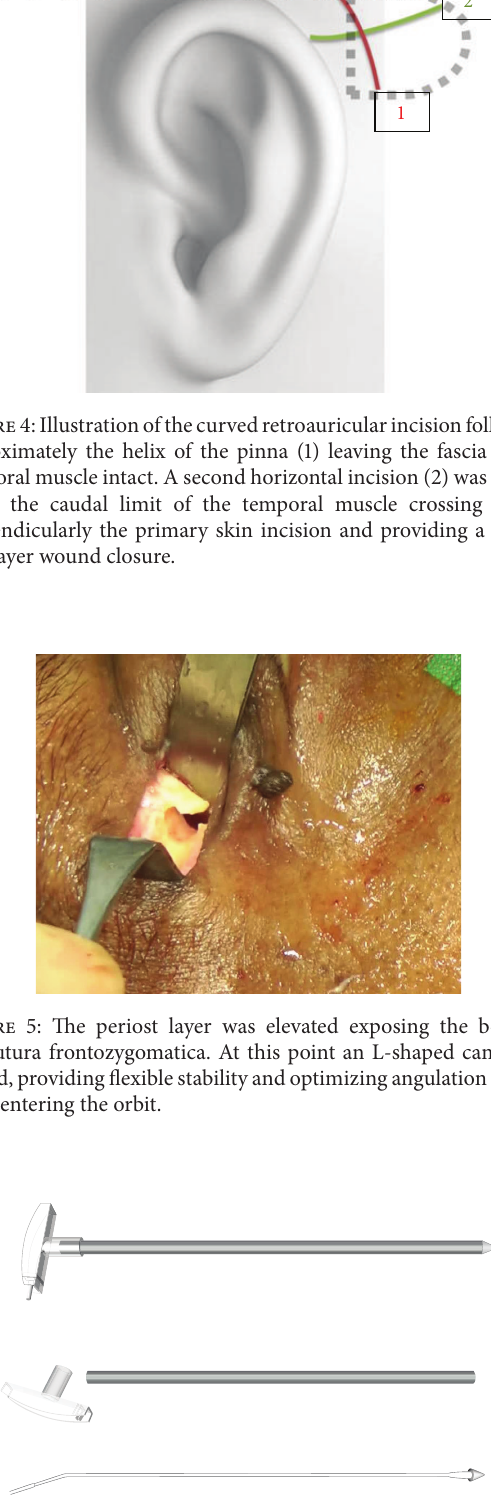
Figure 6: A custom made hollow trocar was advanced from the periorbital region subperiosteally to the retroauricular area. The cone end of the trocar was removed and the sensitive implant chip was placed inside the trocar tube. Retracting the trocar with the implant chip allowed safe passage of the subperiosteal